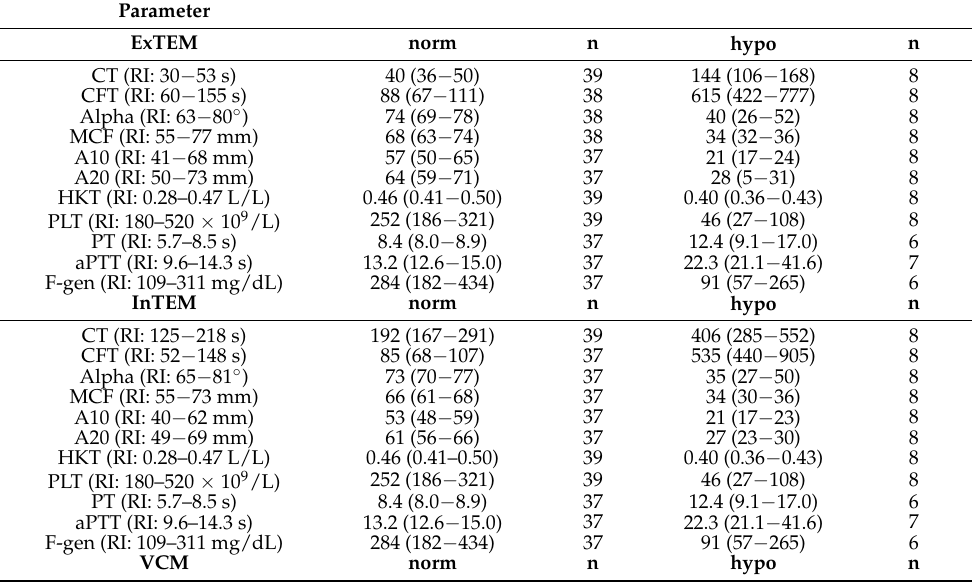
Table A3. Median (interquartile range) of laboratory parameters of dogs that were concordantly normo- or hypocoagulable in all three tests (ROTEM and